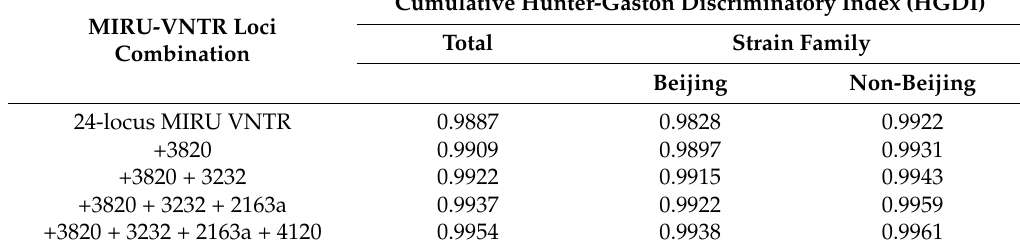
Table 2. The discriminative power of the different combinations of Mycobacterial Interspersed Repetitive Units-Variable Number of Tandem Repeats (MIRU-VNTR) loci.